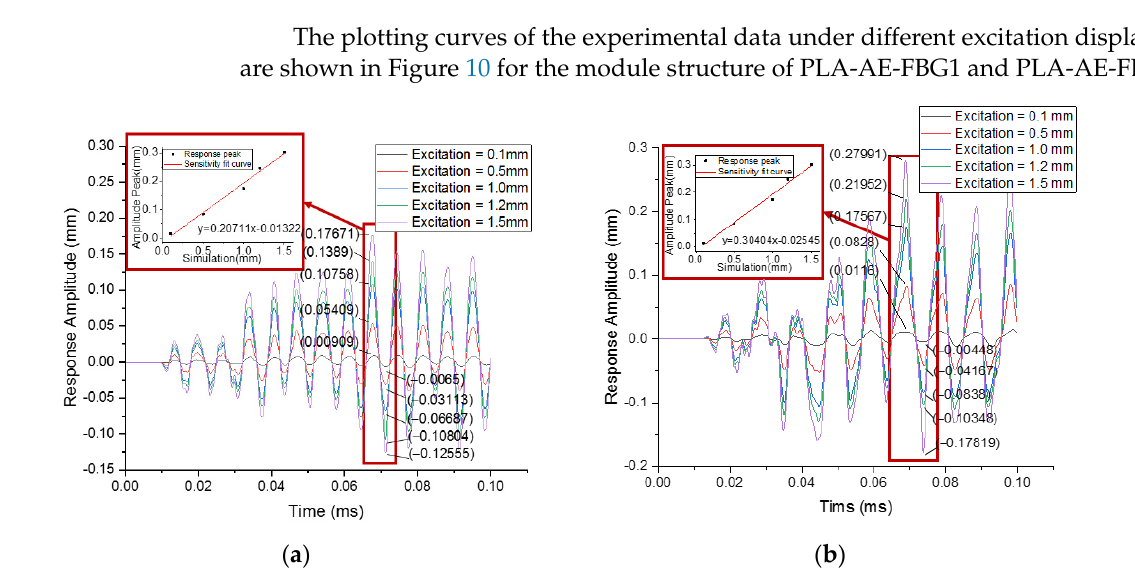
Figure 10. The response curve under different excitation signals. ( a ) PLA-AE-FBG1 structural response curve; ( b ) PLA-AE-FBG2 structural response curve.